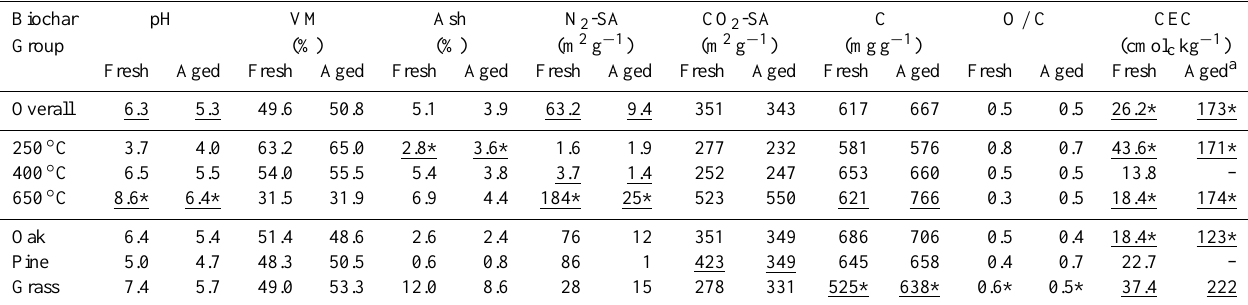
Table 3. Mean values of various parameters for fresh and aged biochars as a whole ( n = 18) and grouped. The difference between fresh and aged biochar is significant, computed by Type-1, paired T test, at p < 0 . 1 when underlined and only p < 0 . 05 level when also with an asterisk.